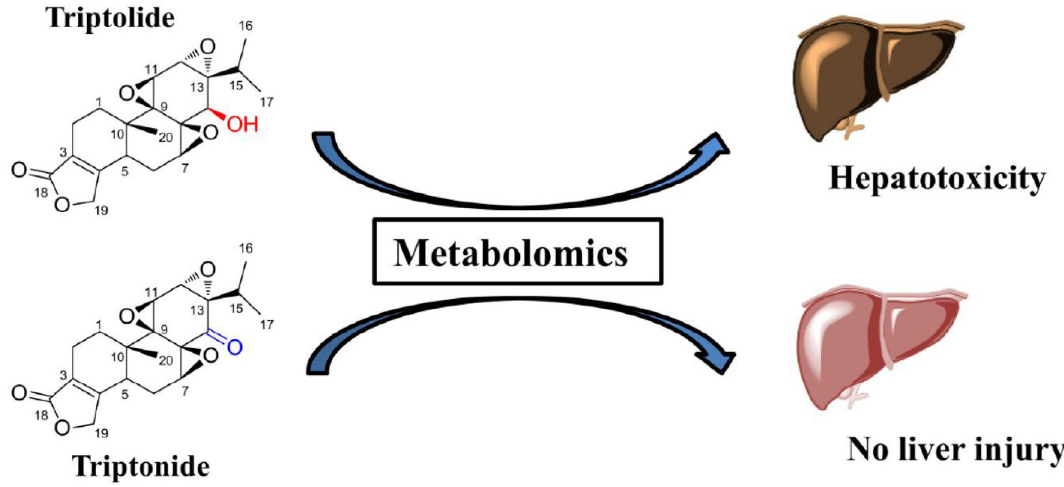
Fig. 9 Differential metabolisms of triptolide and triptonide. Reproduced with permission from [5]